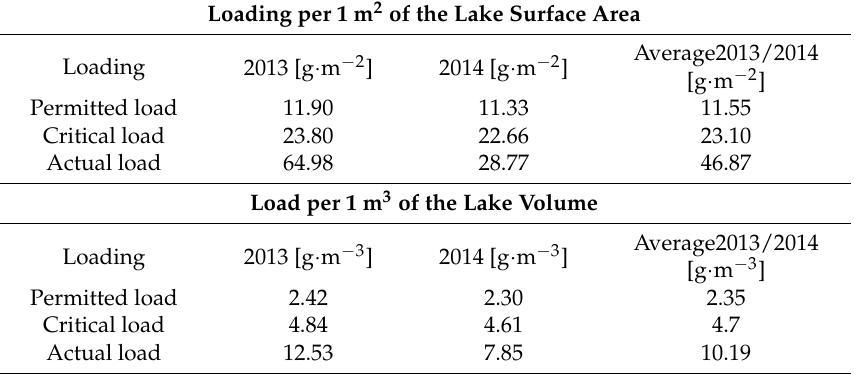
Table 4. Loading with the permitted load, critical load, and actual nitrogen load according to a hydrological model proposed by Vollenweider [5] per 1 m 2 of the lake surface area and 1 m 3 of the lake